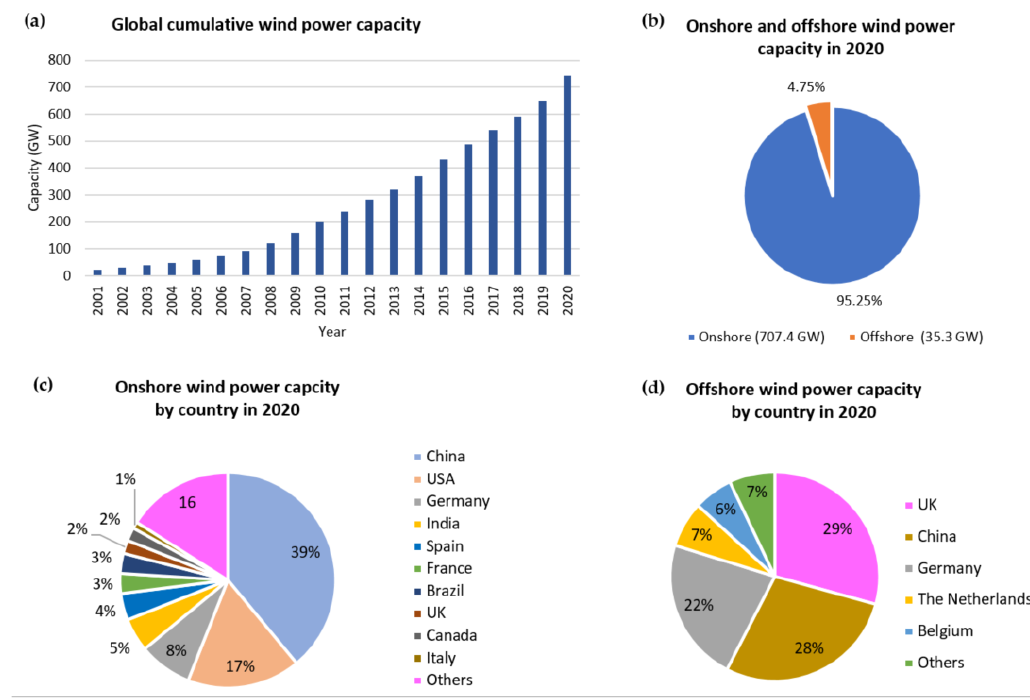
Figure 2. Global wind power capacity statistics in 2020.